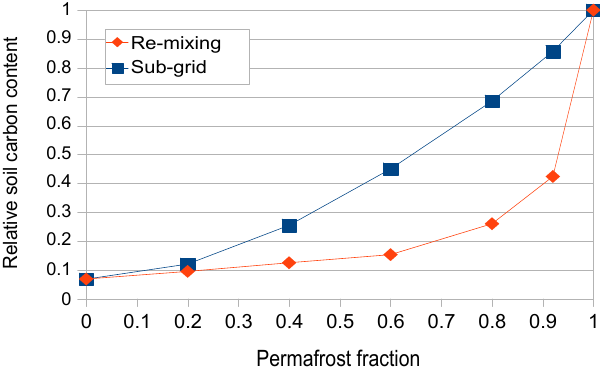
Figure 3. Comparison of sub-grid to remixing approach for relative soil carbon contents of a grid cell for increasing permafrost frac- tion. The variables of mean annual temperature and frost index vary with permafrost fraction according to data relationships upscaled to CLIMBER-2 grid relationships (see Appendix A and Fig. A2).